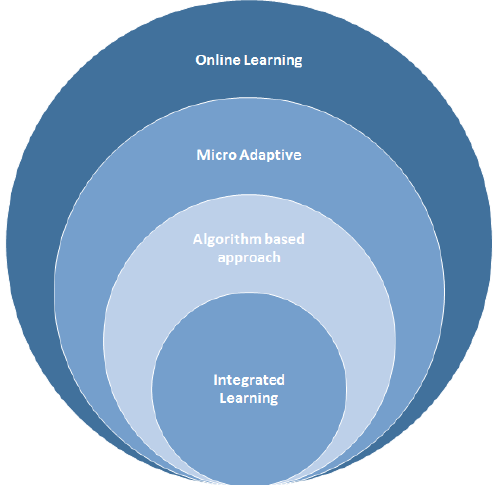
Figure 3. Adaptive learning